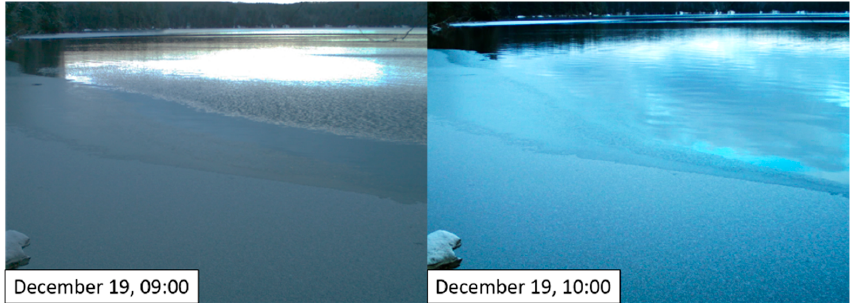
Figure 7. The early image (left, closest in situ image to the acquisition time of the RADARSAT-2 image) shows the presence of frost flowers and a rough lake surface, which possibly results in a higher backscatter value. This is compared to the later image (right), which shows a relatively smooth surface. Both images were acquired from the same camera on Johnson